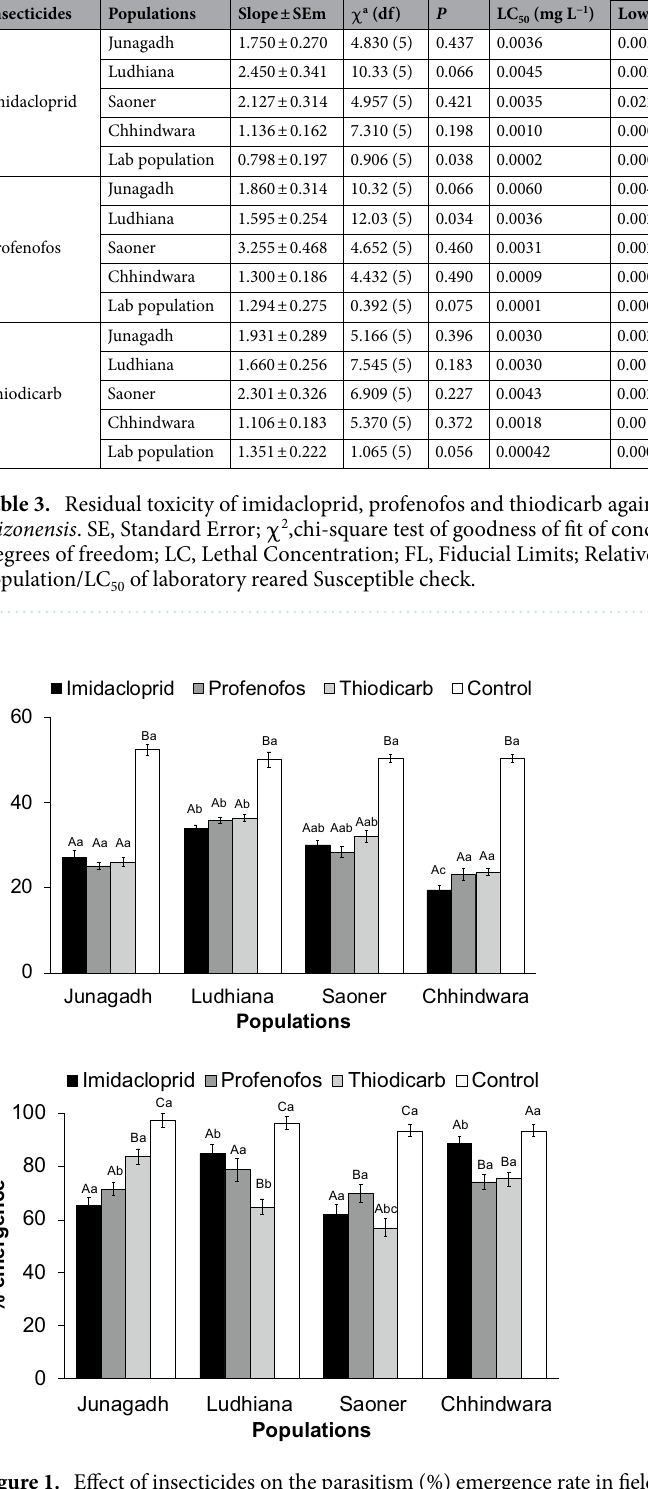
Figure 1. Effect of insecticides on the parasitism (%) emergence rate in field populations of mealybug parasitoid, A.arizonensis. Mean ± SE parasitism rate ( a ) and progeny emergence rate ( b ) of Aenasius arizonensis females exposed by contact residue of LC50 of imidacloprid, profenofos and thiodicarb. Significant effect of the factors insecticides, populations and their interactions on both the parasitism rate and the emergence rate. All the tested insecticides negatively affected the parasitism and the emergence. Columns bearing the same letter (upper case letters: within the same population; lower case letters: within the same tested insecticide) are not significantly different (LSD post hoc test for multiple comparisons at P ≥